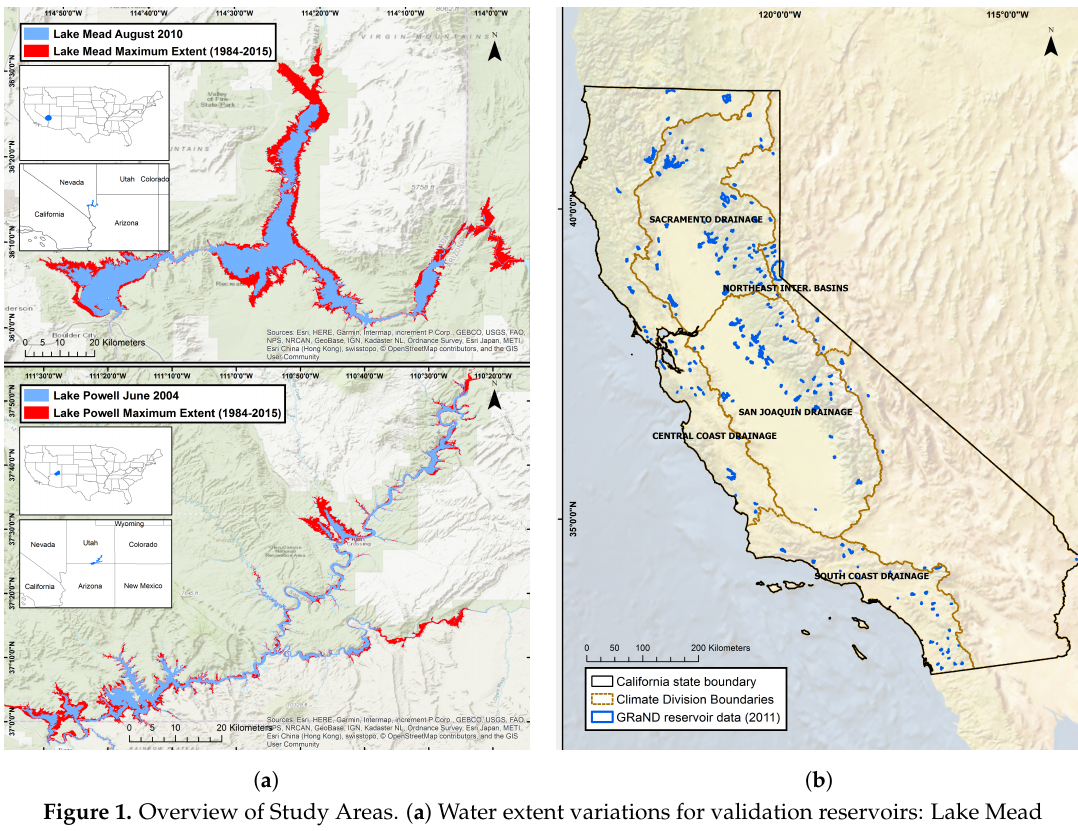
Figure 1. Overview of Study Areas. ( a ) Water extent variations for validation reservoirs: Lake Mead (Top) and Lake Powell (Bottom) between 1984–2015; ( b ) Distribution of reservoirs in California across different climate divisions ( Source: Global Reservoirs and Dam Database